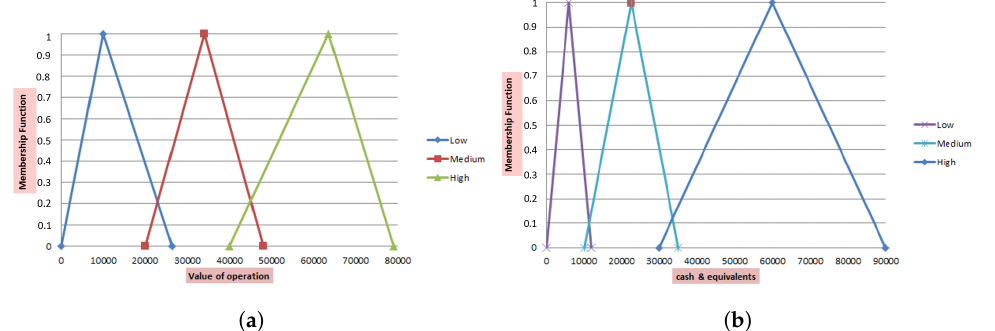
Figure 1. Triangular membership function of the variables ( a ) ‘value of operation’ and ( b ) ‘cash and